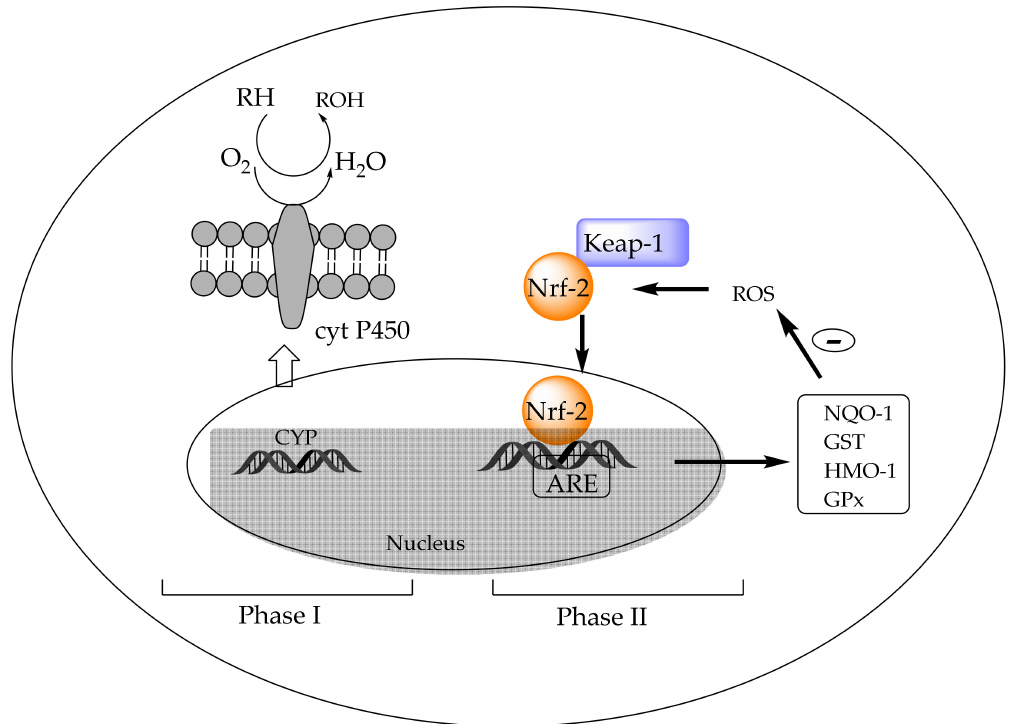
Figure 5. Detoxifying metabolism: Phase I and Phase II. CYP : cytochrome P450 monooxygenase, ARE genes: antioxidant-response elements; Nrf-2: nuclear factor erythroid 2 related factor 2; Keap-1: Kelch-like epichlorochydrin-associated protein 1; NADPH quinine oxidoreductase 1: NQO-1; glutathione S-transferase: GST; heme oxygenase 1: HMO-1; glutathione peroxidase: